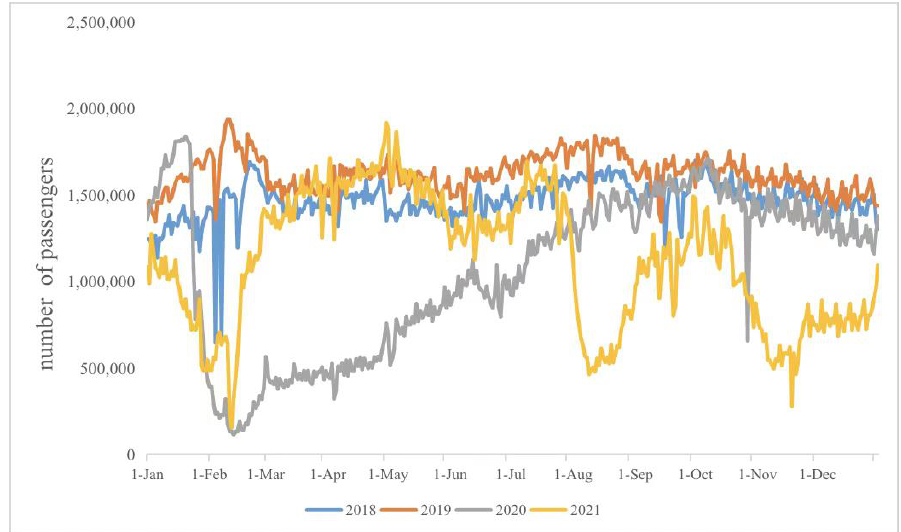
Figure 1. Changes of air passengers before and after COVID-19 in China.